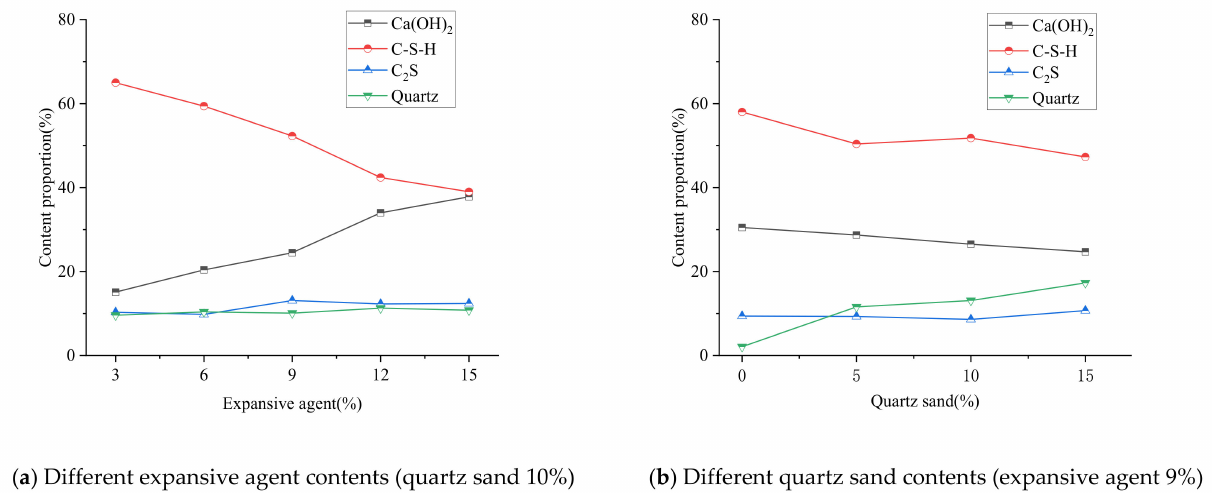
Figure 5. XRD phase compositions of expansive grout